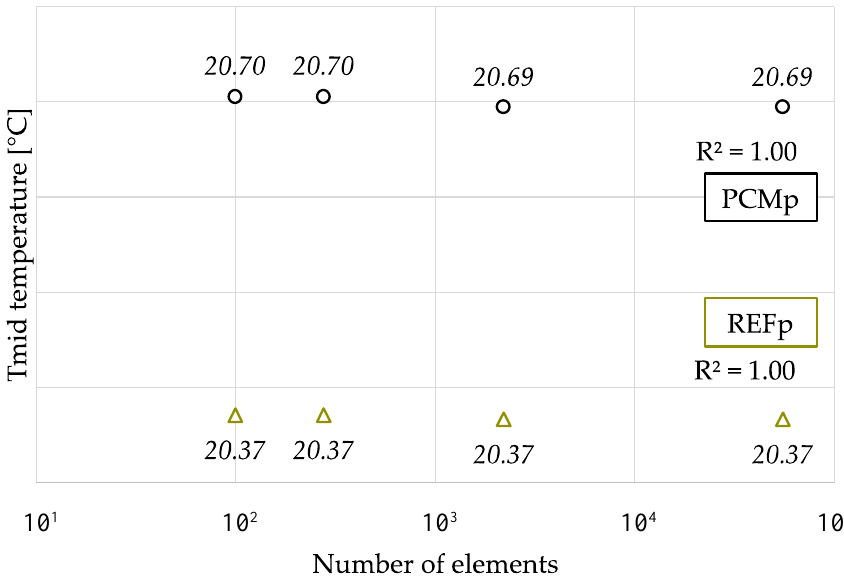
Figure 6. Calibration of the unsteady–state tests. ( a ) Test with the reference plaster, ( b ) test with the PCM plaster.